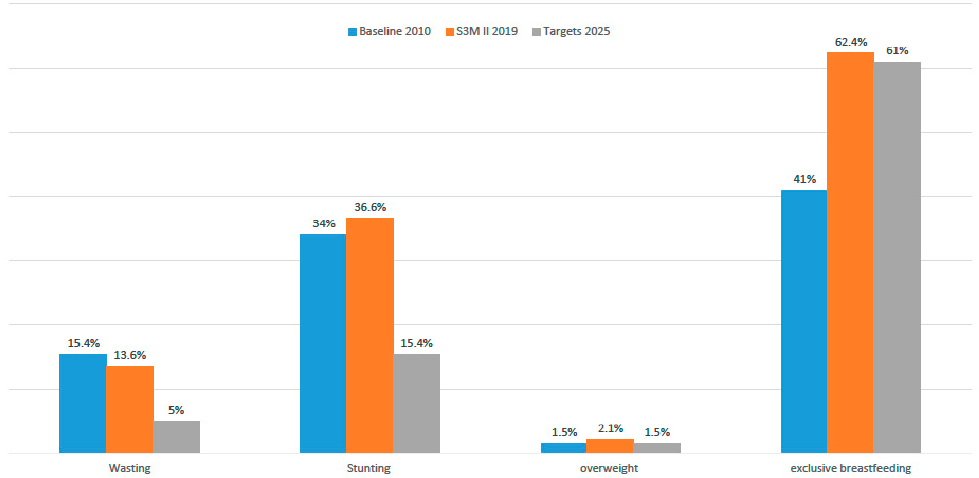
Figure 1. Tracking the Global Nutrition Targets based on the S3M II results.